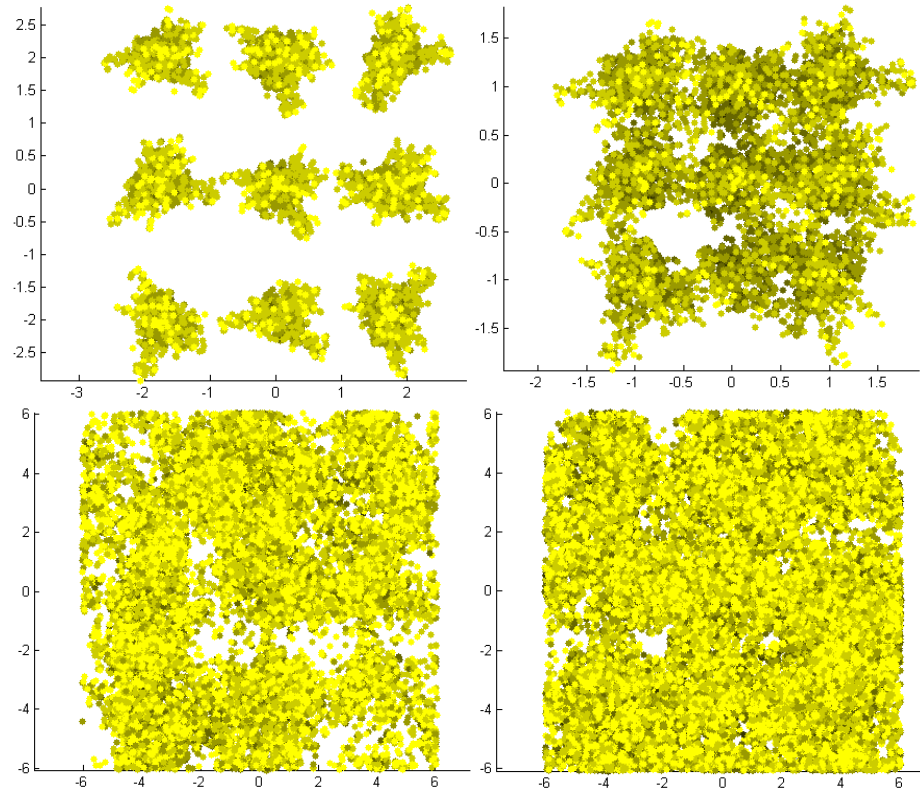
Figure 3. PBRT generated APAR per leaf for all 3D simulated stands. The four figures present the nadir view of the stands with LAI 0.58, 1.29, 2.76, and 3.65, respectively. The leaves are separated in percentage classes of absorbed light ranging from yellow (80%–100% absorbed light) to black (0%–5% absorbed light). Sun is at 10° from nadir. The axes of the figures indicate the stand dimensions in meters.